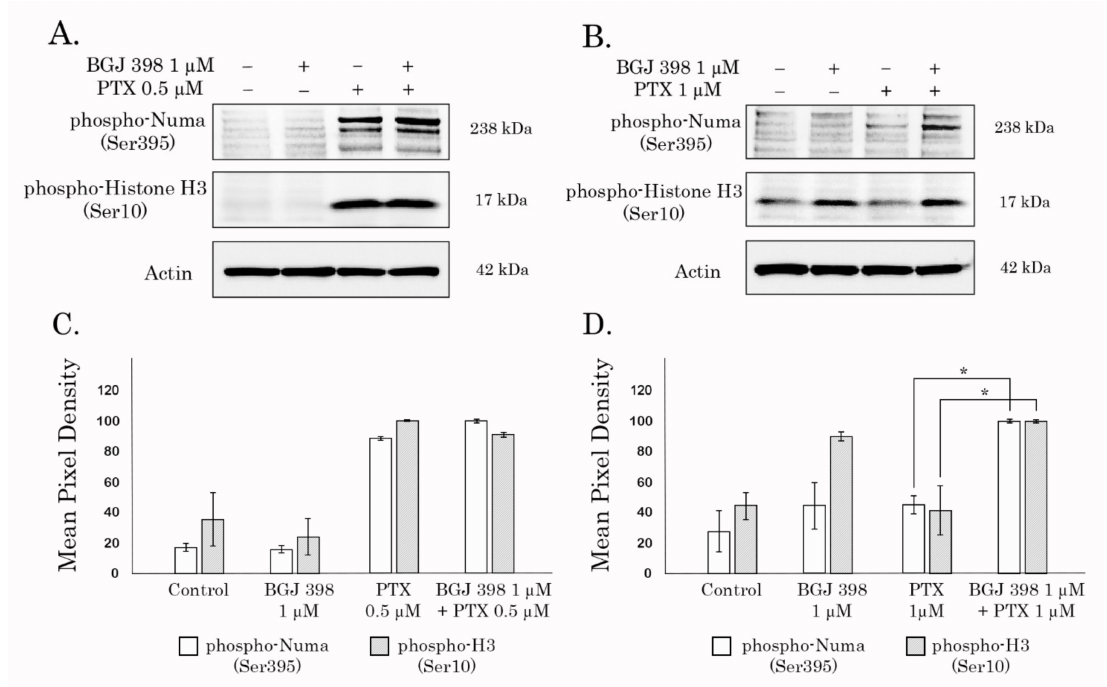
Figure 4. BGJ 398 increases intracellular accumulation of Calcein, an ABCB1 fluorescent substrate, in ABCB1-overexpressing Tx-R HCC 1806 cells. The intracellular accumulation of Calcein, a fluorescent product of the ABCB1 substrate Calcein AM, was determined in the Tx-R HCC 1806 cells ( B ) and the corresponding drug-sensitive parental HCC 1806 cells ( A ). The cells indicated above were treated with 100 nM of Calcein AM alone (green) or in combination with 20 µ M of BGJ 398 (red) or 50 µ M PD 173074 (gray). The fluorescence intensity was analyzed by FACs. Representative hist grams of at least 3 independent experiments are shown.